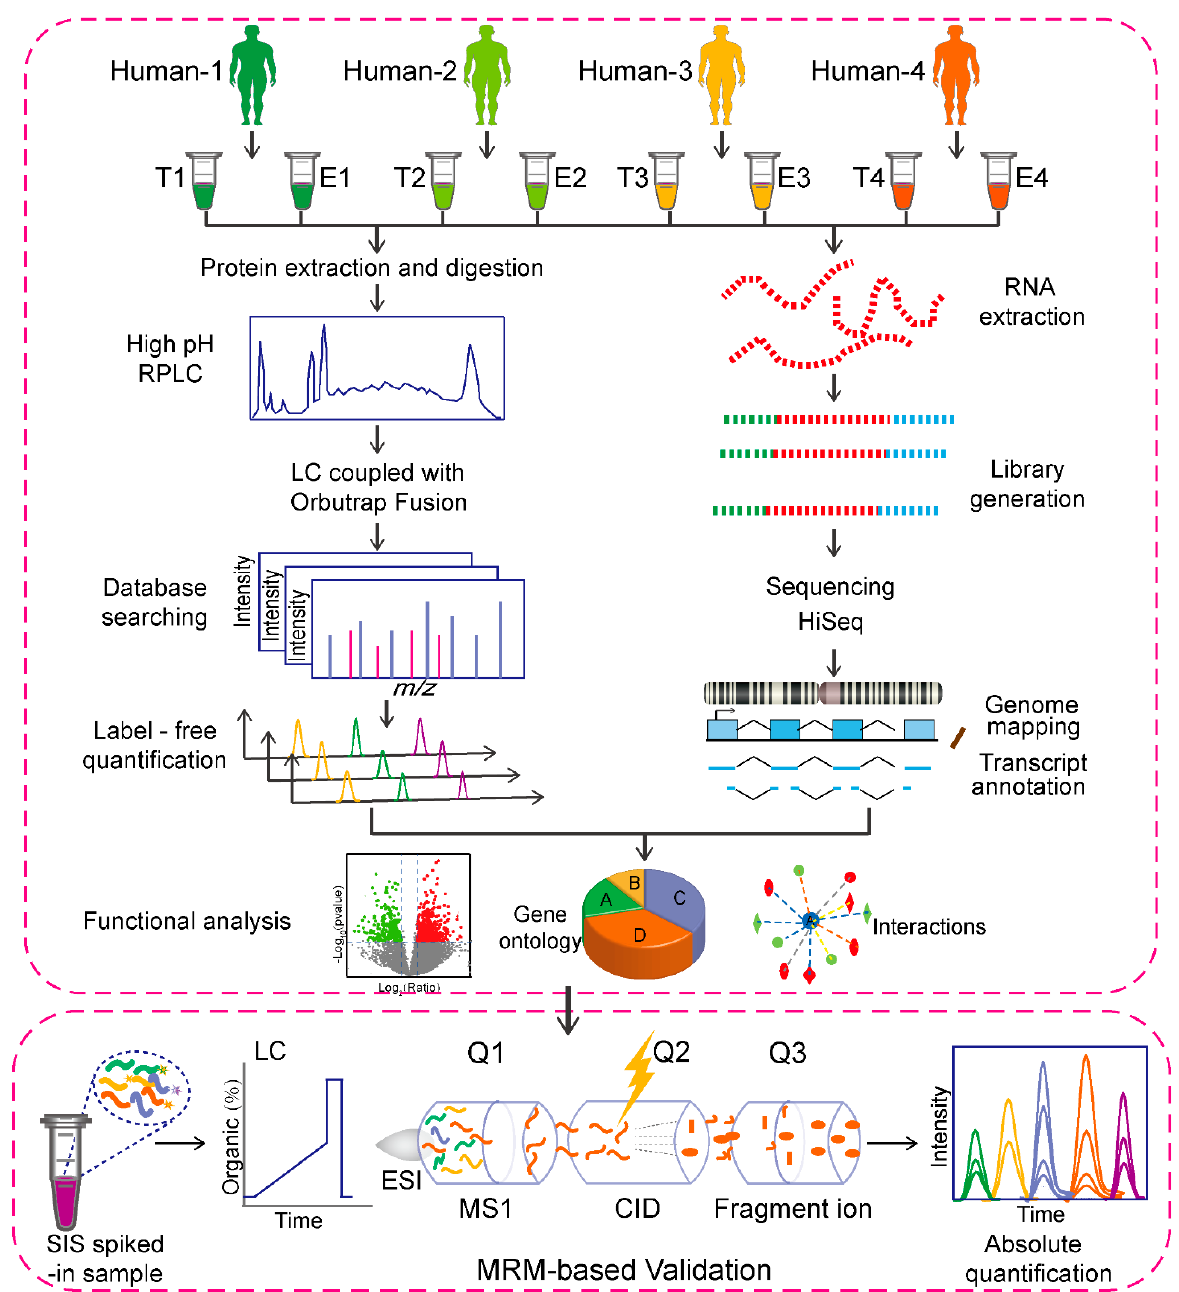
Figure 1. Experimental workflow for the proteomics and transcriptional analysis of testis and epididymis samples, and further validation of selected proteins by utilizing the MRM technique.